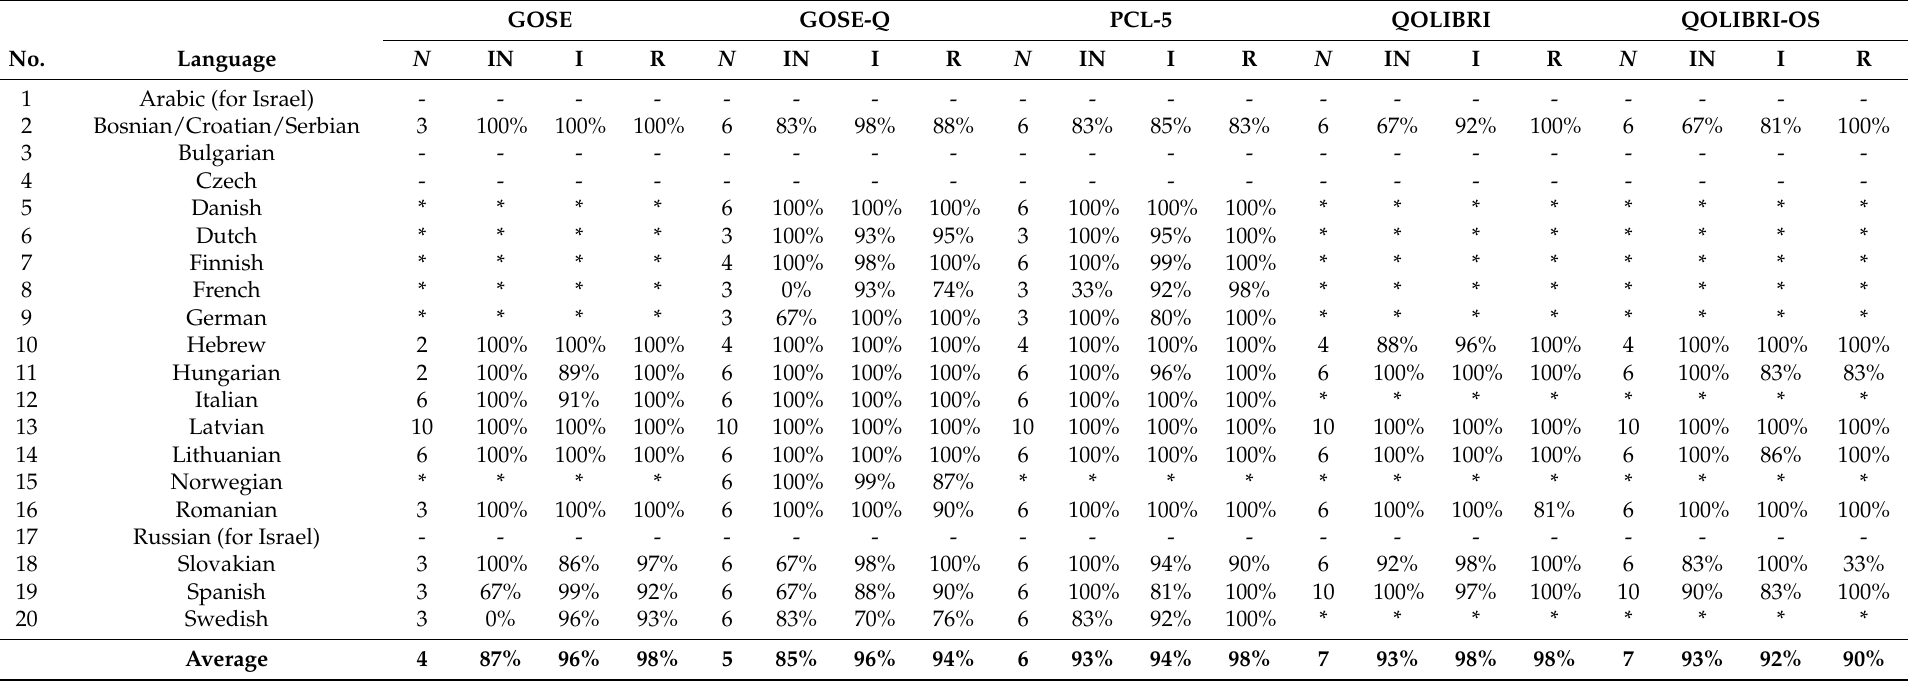
Table 6. Average comprehension rates per language and outcome instrument in the cognitive